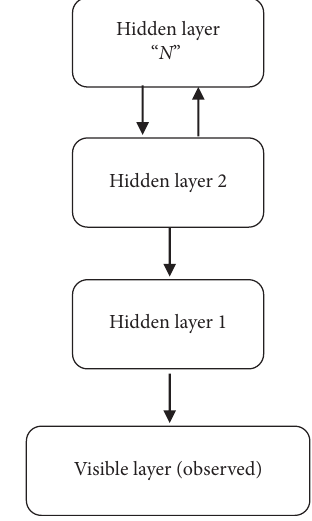
Figure 9: Structure of basic DBN Table 4: ECG databases for arrhythmia classification.